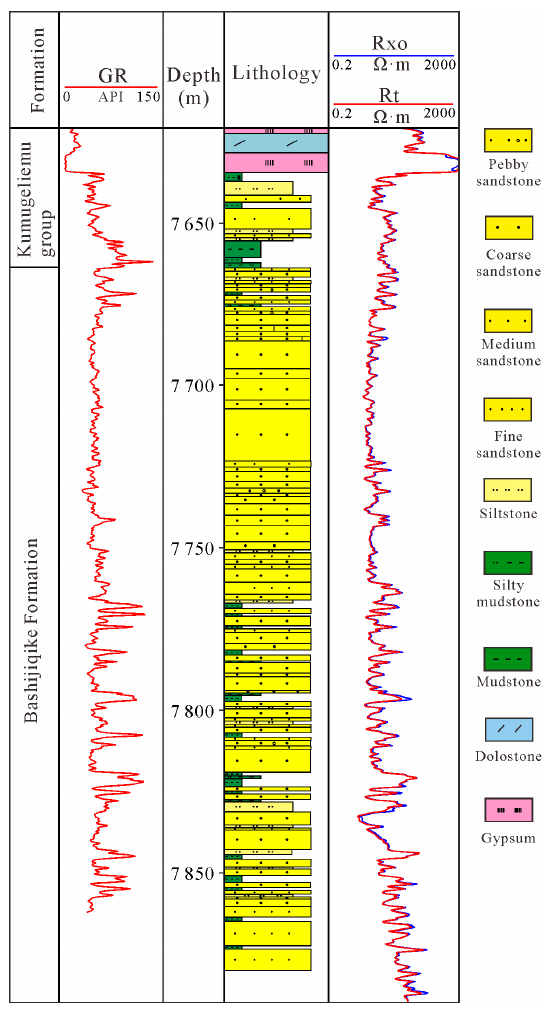
Figure 2. The lithology section and well log curves of Well Bozi 9 in the Kuqa Depression (Zeng et al.,